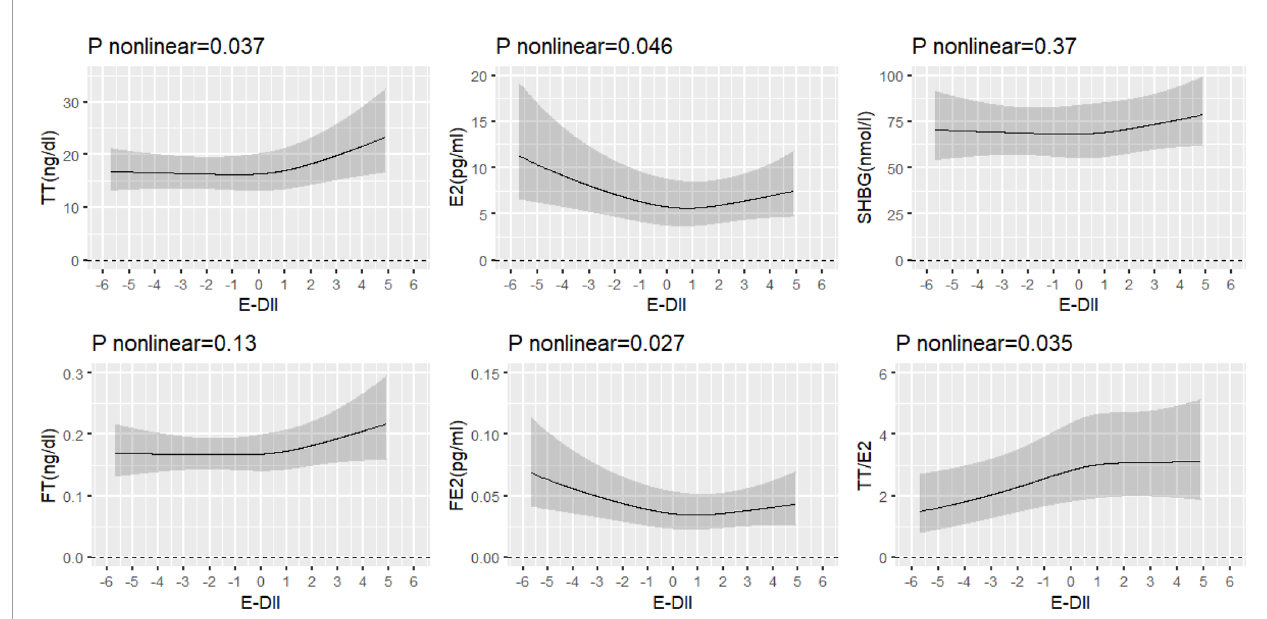
FIGURE 2 | Restricted cubic spline models of association between E-DII and sex hormones. E-DII, energy-adjusted dietary in fl ammation index; TT, total testosterone; FT, free testosterone; E2, estradiol; FE2, free estradiol; SHBG, sex hormone-binding globulin; TT/E2, the ratio of TT to E2. All models were adjusted for age, race, education, marital status, smoking, body mass index, waist circumference, type of menopause, time since menopause, parity, time of blood sampling and energy intake.